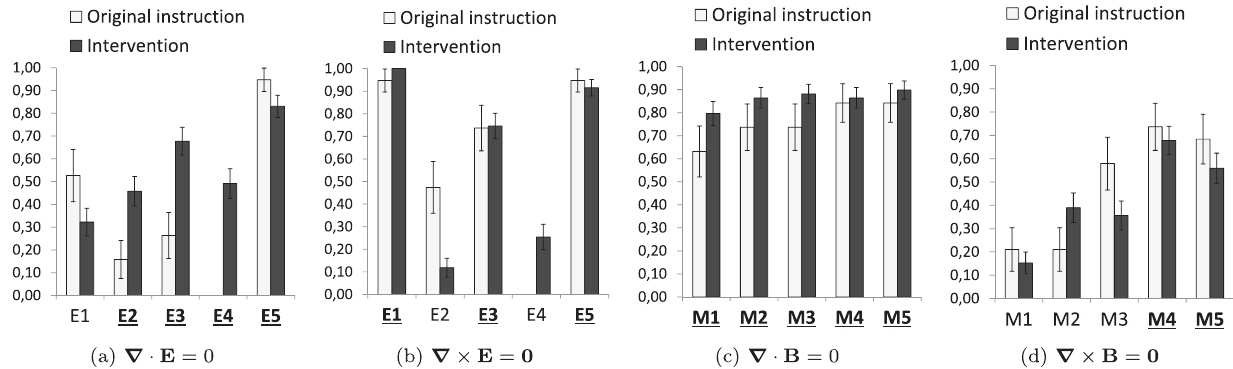
FIG. 14. Proportion of students who indicated the divergence or curl is zero in each situation on the post-test (Fig. 13) after the original instruction ( N ¼ 19 ) and the intervention ( N ¼ 59 ). Correct answers are in bold and underlined. We omitted the data after the original instruction for situation E4, since this situation was described ambiguously at that